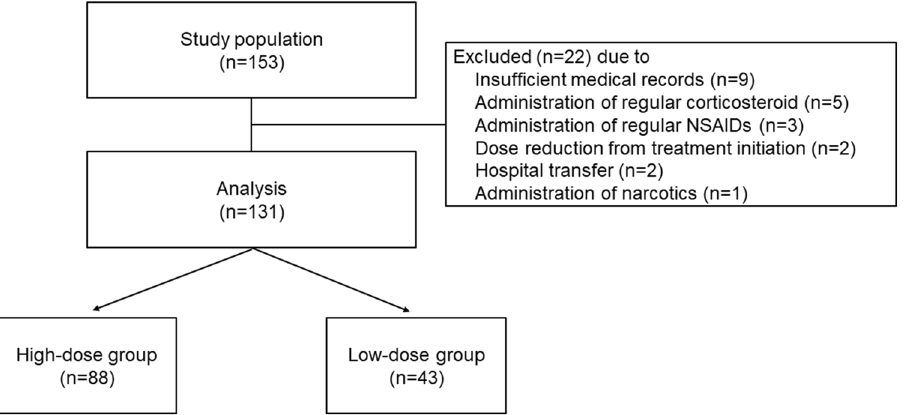
Figure 1. Design of this study. NSAIDs non-steroidal anti-inflammatory